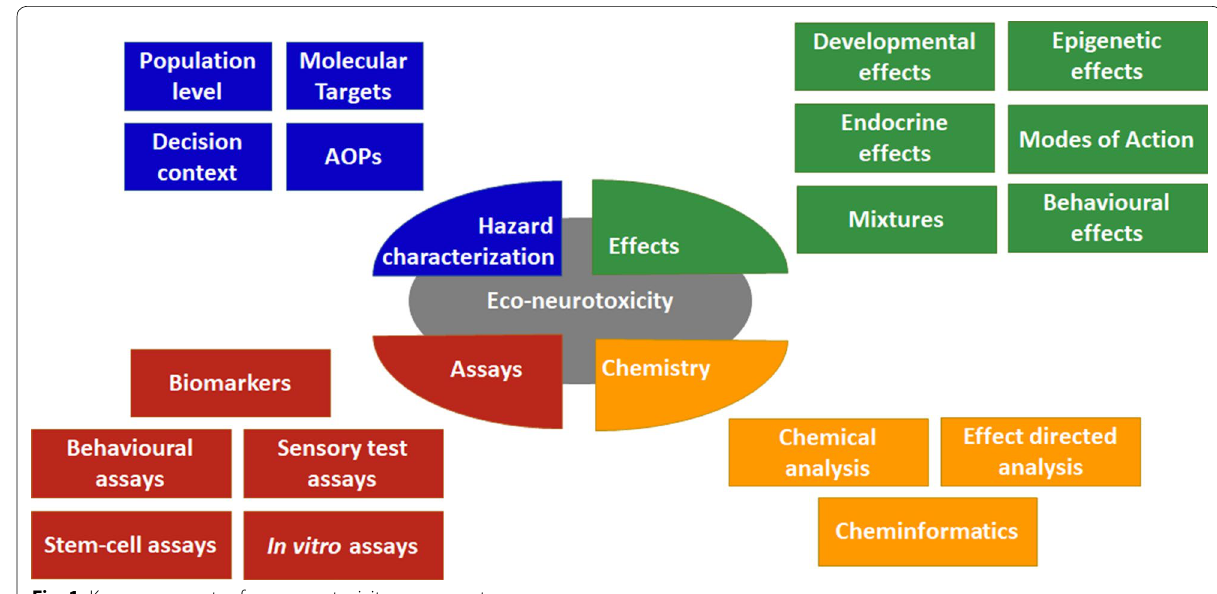
Fig. 1 Key components of eco‑neurotoxicity